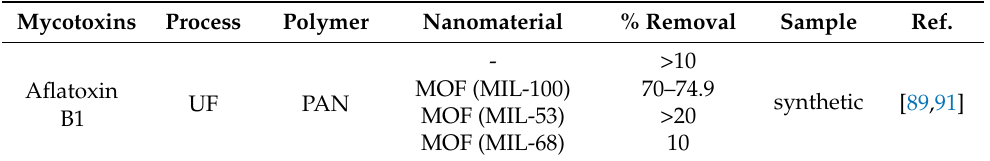
Table 6. Application of polymeric membranes in the purification of water contaminated with